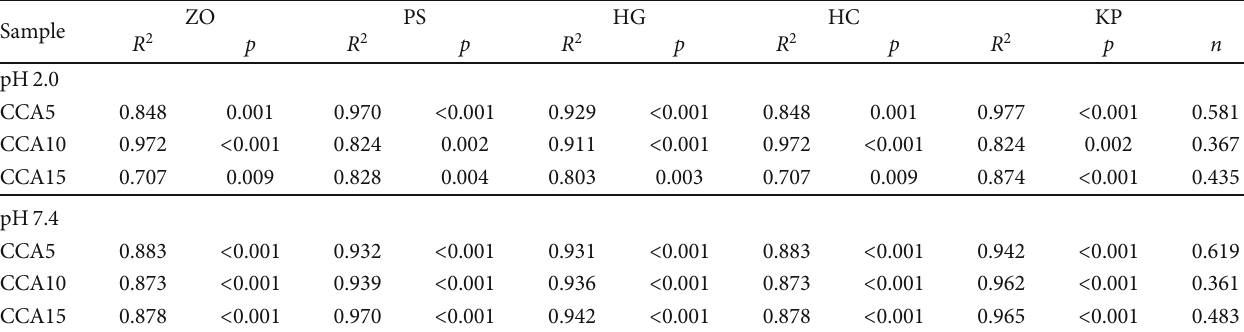
Table 2: R 2 , p , and n of kinetic models re fl ecting the release process of allopurinol from CCA biocomposite fi lms to pH 2.0 and pH7.4 solutions.